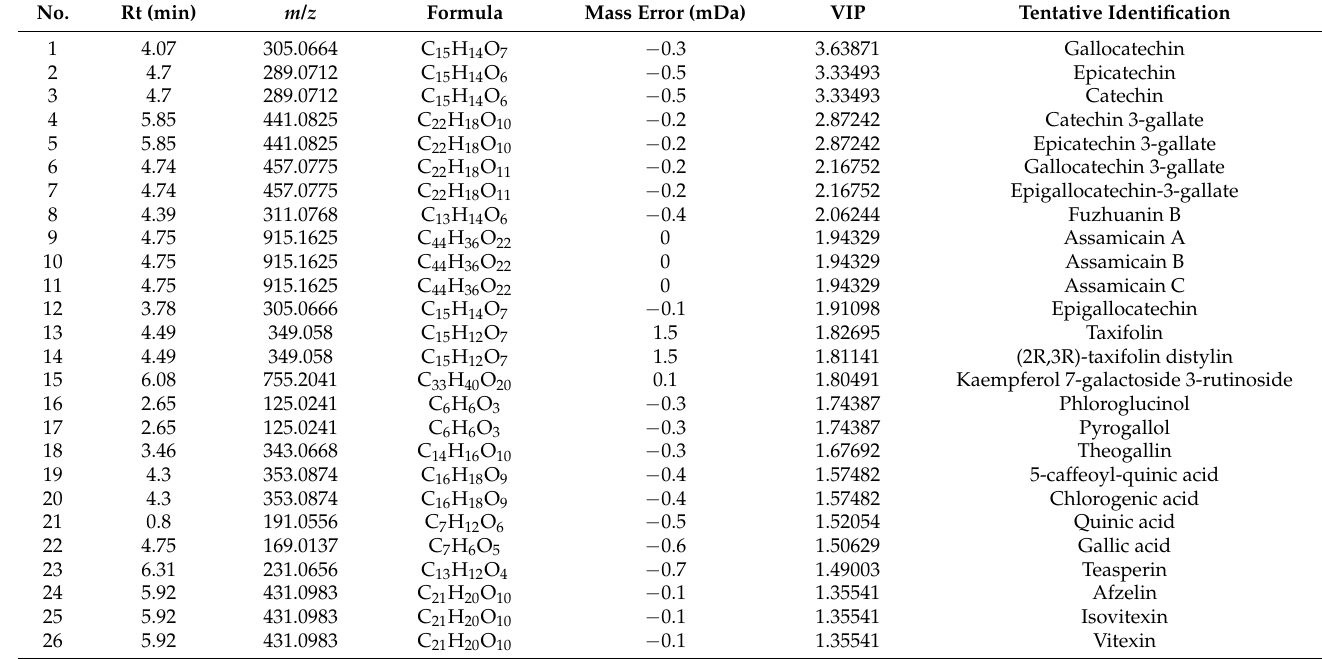
Table 3. Critical metabolites (VIP > 1.0) responsible for the metabolomics variations caused by FBT processing.